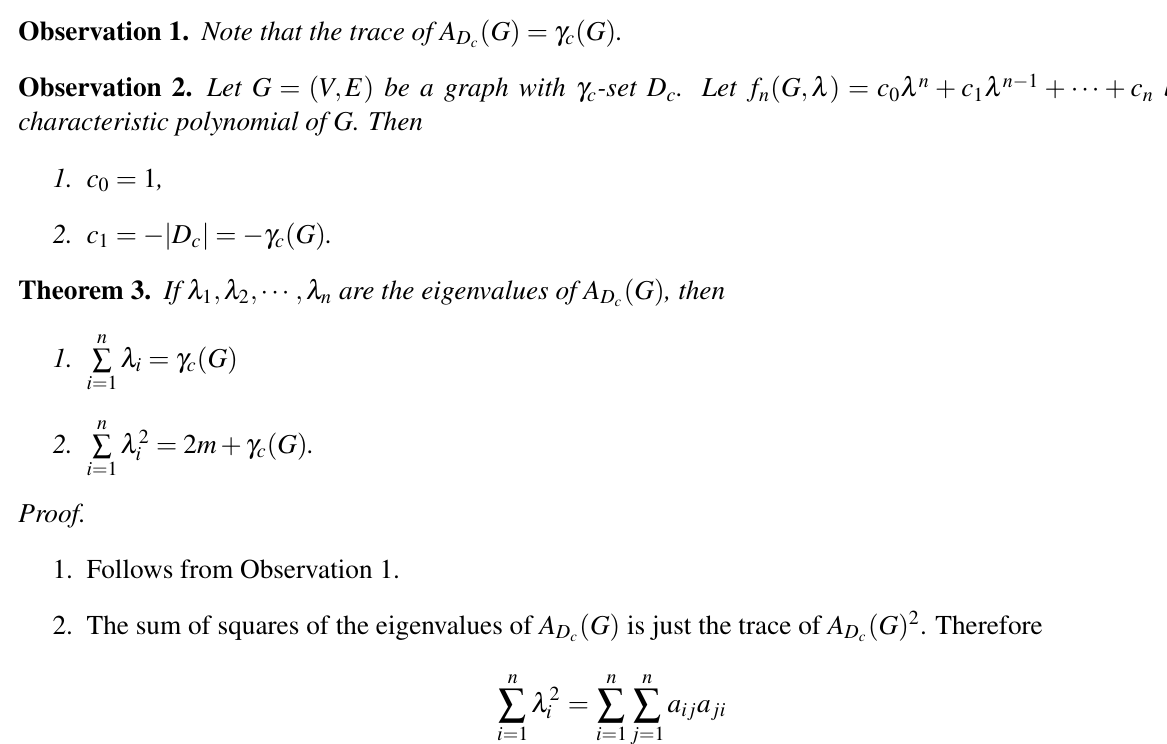
( G ) with heats of vaporization of c